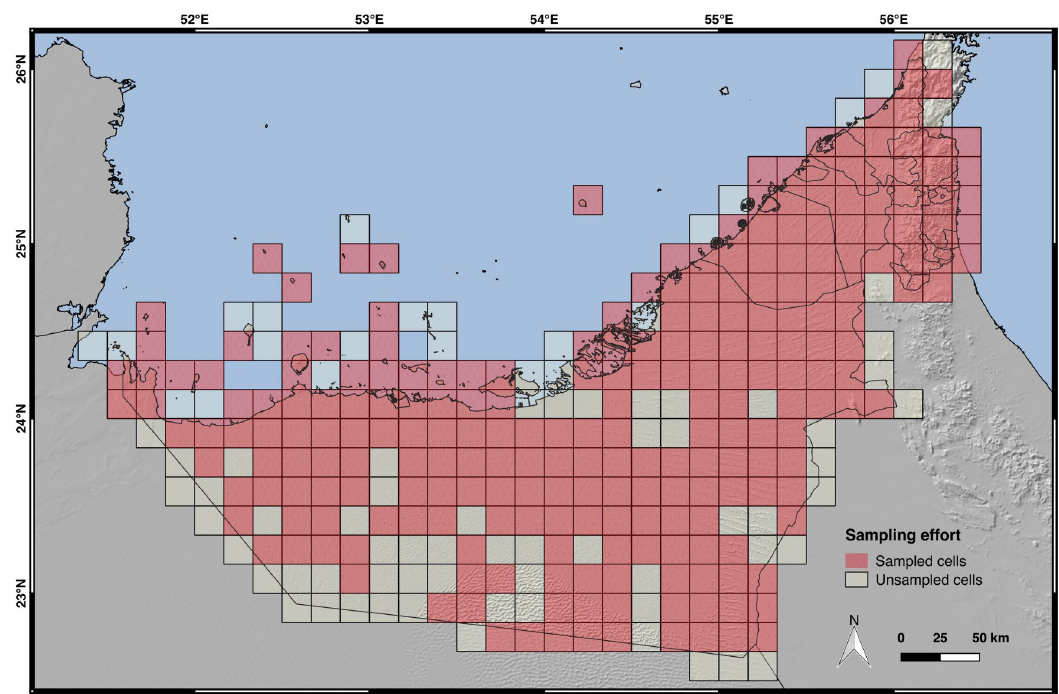
Fig 2. Map of the sampling effort. Grids of 10 arc-minutes (~18x18 km) with observations (red cells). Empty grids can be either no observations or no sampling. Credits: OpenStreetMap contributors, SRTM.